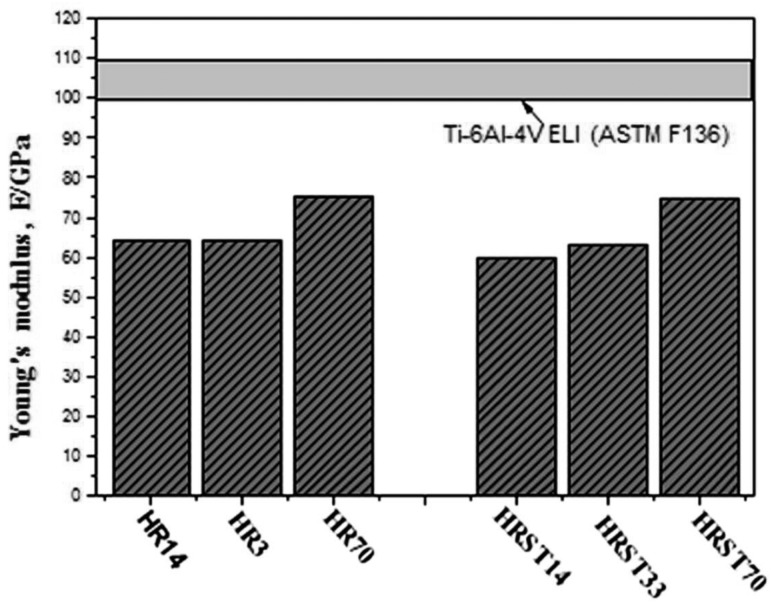
Young’s moduli of TNTZ-0.14O, TNTZ-0.33O and TNTZ-0.70O subjected to hot rolling (HR14, HR33 and HR70), and solution treatment at 1003, 1083 and 1243 K for 3.6 ks after hot rolling (HRST14, HRST33 and HRST70), respectively.